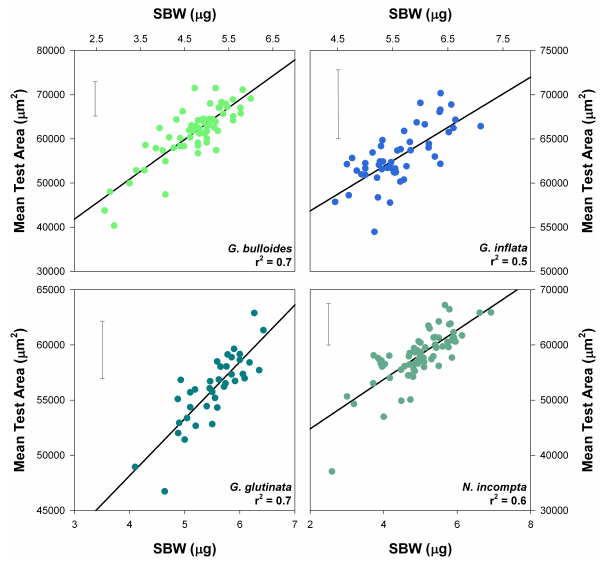
Fig. 1. The mean sieve-based test weight (SBW; µg) versus the mean test area (µm 2 ) for aliquots of planktic foraminifera sam- pled using a multiple-opening-closing net in the North Atlantic Ocean picked from the 200–250µm sieve fraction. The corre- lations observed (0.5 <r 2 < 0 . 7; p< 0.0001) suggest that typically “narrow” sieve fractions provide an insufficient control on the size- determined variations in test